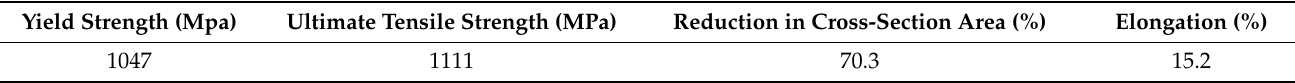
Table 2. Mechanical properties of